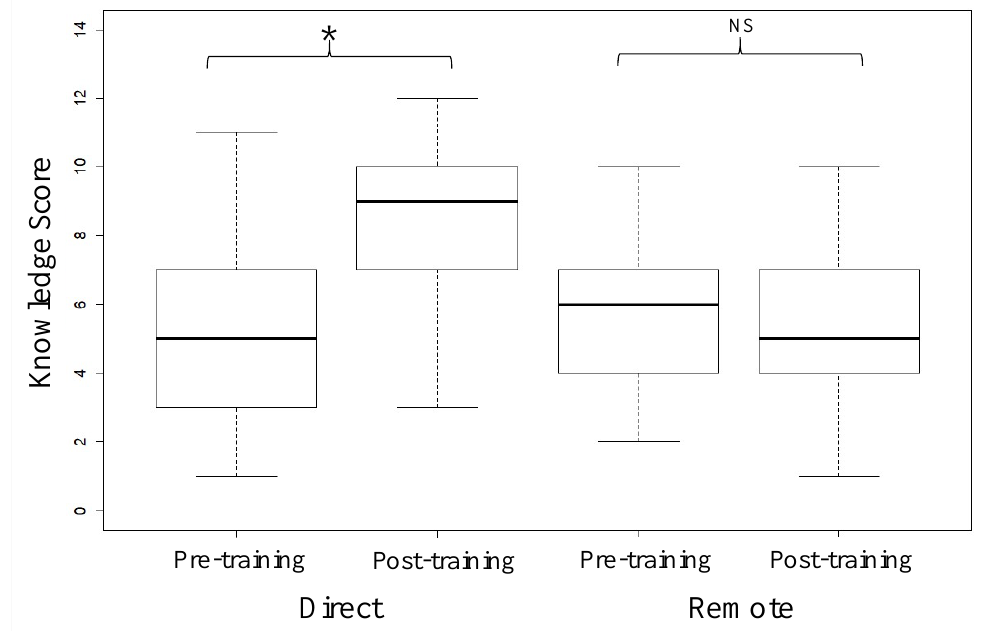
Table 3. Minimum Adequate Model (MAM) summaries of principal components one and two obtained from a PCA of attitudinal responses, and Knowledge score using backward stepwise selection. Change ( Δ) in AIC is the decrease in Akaike Information Criterion from the full model (~Gender + Age + Education + Time in industry, Type of living area).